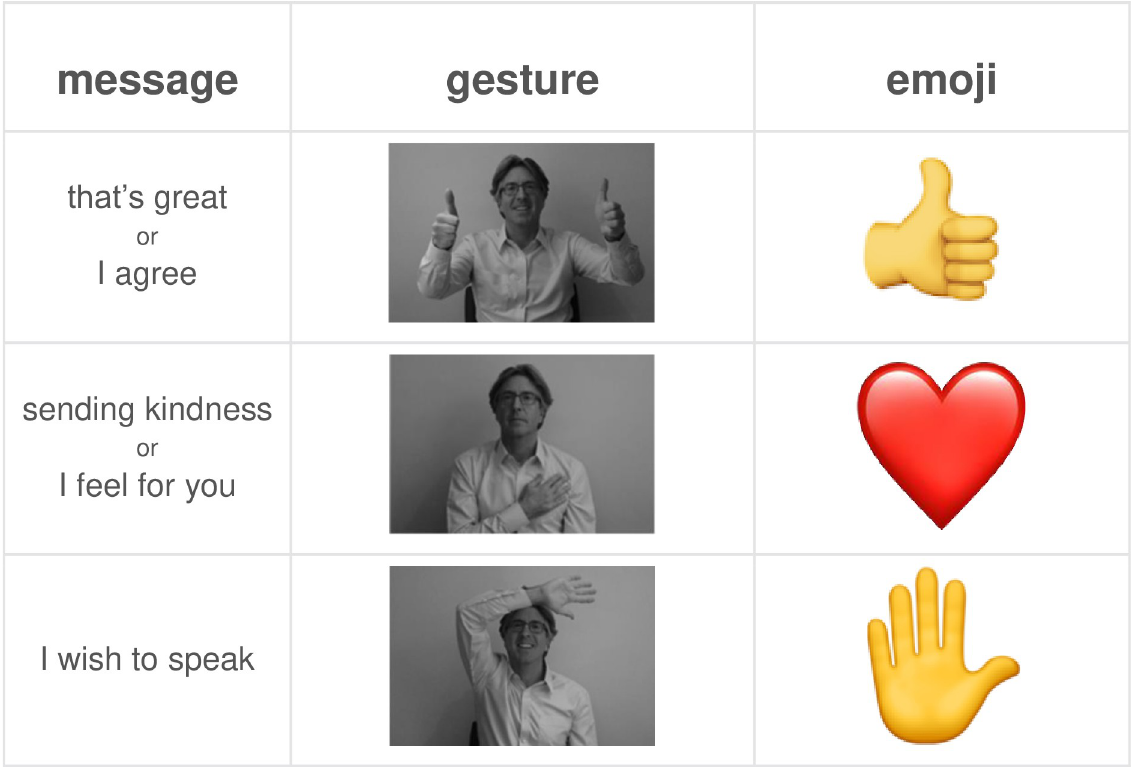
Fig 3. Signals used in the gesture and emoji groups in Experiment 2. Emoji’s appeared superimposed in top right corner of participants’